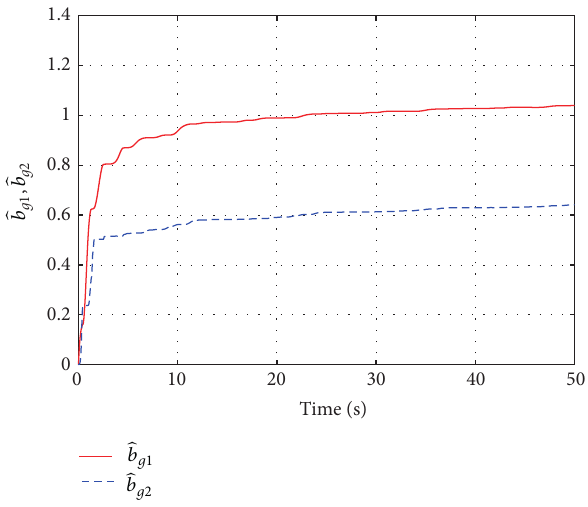
̂𝑏 Figure 7: 𝑔 1 (real line) and